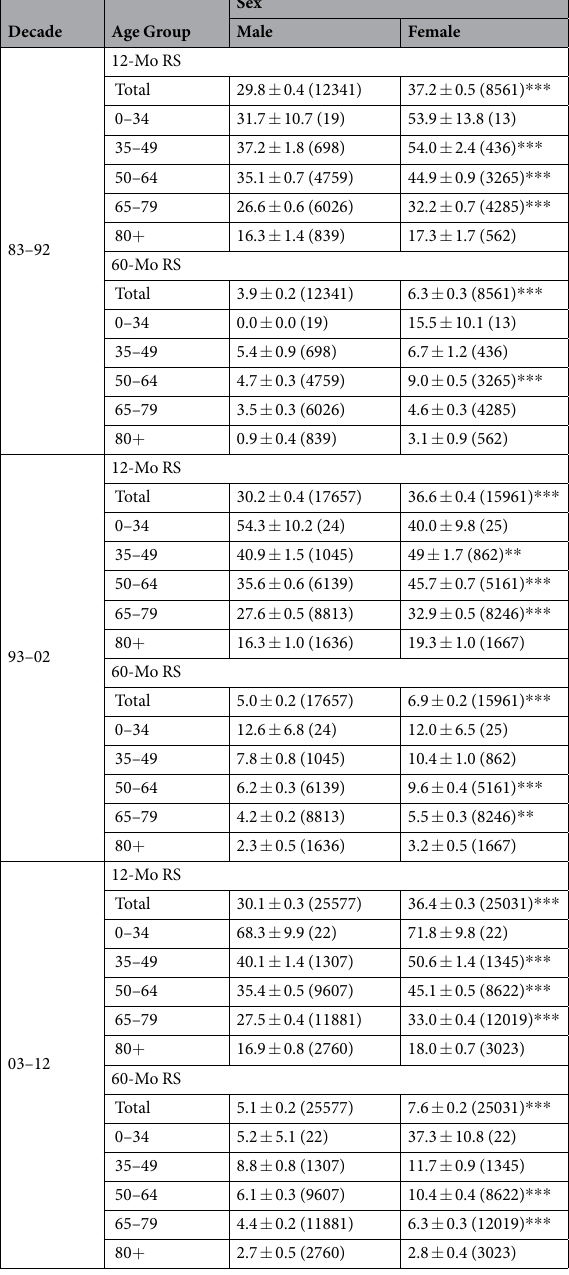
Table 2. 12-month 60-month relative survival rates of SCLC patients according to sex, age group, and calendar period from 1983 to 2012 at 18 SEER sites. Data are means ± standard error of the mean, with number of patients in parentheses. Abbreviations: mo, month; RSR, relative survival rate; SEM, standard error of the mean. * p < 0.01, ** p < 0.001, and *** p < 0.0001 for comparisons with the Male